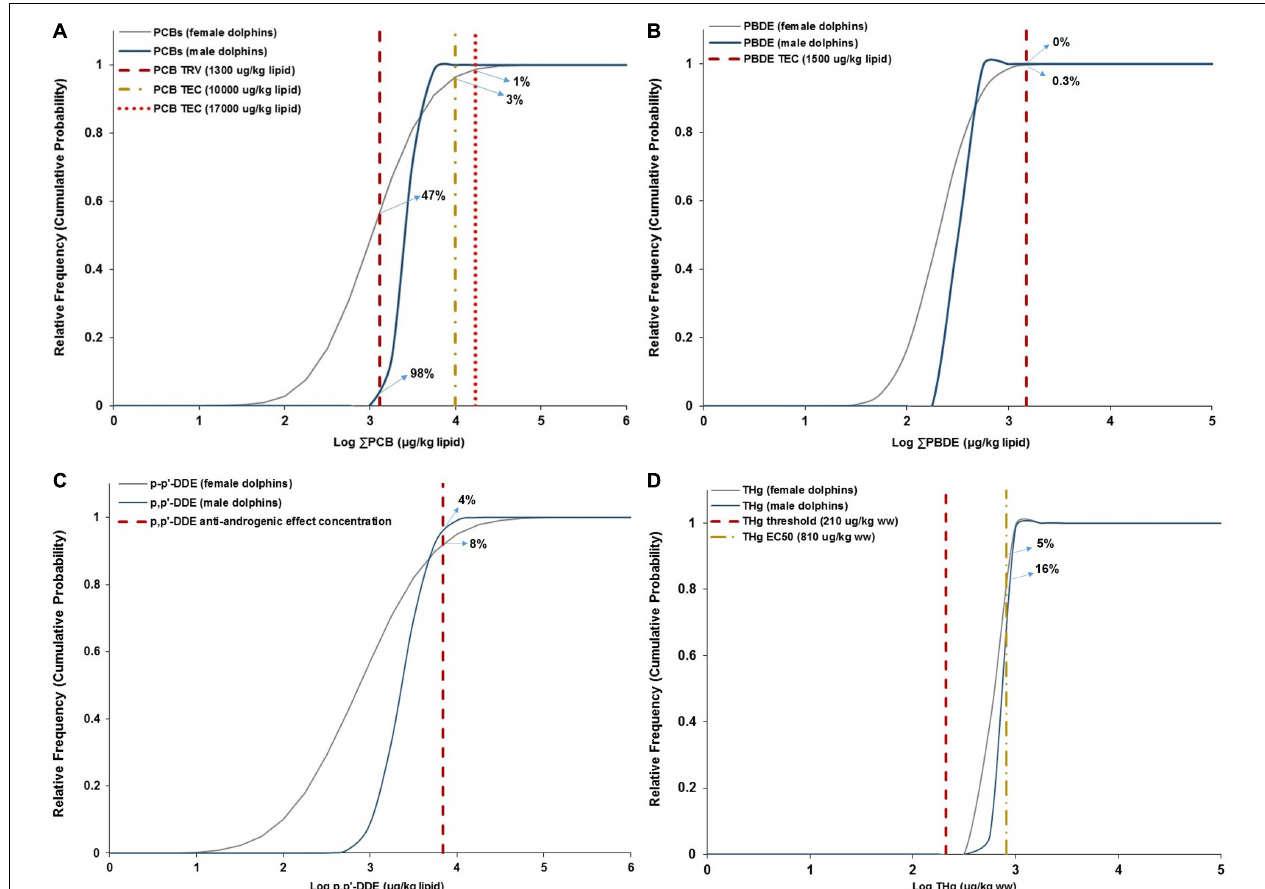
FIGURE 6 | Cumulative probability (frequency) distribution of log-transformed concentrations of PCBs, PBDEs and p,p (cid:48) -DDE (in µ g/kg lipid weight) measured in biopsy blubber samples, and THg (in µ g/kg wet weight) measured in biopsy skin samples of female and male bottlenose dolphins to characterize the risk of exposure to reported toxic health effect concentrations in marine mammals. (A) Probability distribution of log-transformed PCB concentrations in adult female (gray curve) and male (blue curve) dolphins in relation to the PCB toxic reference value (TRV) for immunotoxic and endocrine disruption in harbor seals (PCB TRV = 1300 µ g/kg lw in red dashed line; Mos et al., 2010), the PCB threshold (PCB TEC = 10000 ug/kg lw in yellow dotted-dashed line) affecting the population growth rate in bottlenose dolphins (Hall et al., 2005); and, the PCB toxic effect concentration (PCB TEC = 17000 µ g/kg lipid in dotted red line) causing reproductive and immunotoxic impairments in marine mammals (Ross P. S. et al., 1996; Kannan et al., 2000). (B) Probability distribution of log-transformed PBDE concentrations in adult female (gray curve) and male (blue curve) dolphins compared with the PBDE toxic effect concentration associated (PBDE TEC = 1.5 mg/kg lw in red dashed line) to thyroid hormone endocrine disruption in gray seals (Hall et al., 2003). (C) Probability distribution of log-transformed p,p-DDE concentrations in female (gray curve) and male (blue curve) bottlenose dolphins in relation to the p,p-DDE anti-androgenic effect concentration (64 µ g/kg wet weight; Kelce et al., 1995) equivalent to 6890 µ g/kg lipid (red dashed line), using the derivation from Alava et al. (2011) based on Kelce et al. (1995). (D) Probability distribution of log-transformed THg concentrations (in µ g/kg wet weight) in female (gray curve) and male (blue curve) bottlenose dolphins assessed against the THg threshold effect concentration of 210 µ g/kg ww (red dashed line), reducing lymphocyte proliferation in marine mammals (Desforges et al., 2016), and the THg effective concentration causing 50% reduction (THg EC50 = 810 µ g/kg ww in yellow dotted-dashed line) in lymphocyte function of marine mammals (Desforges et al., 2016).